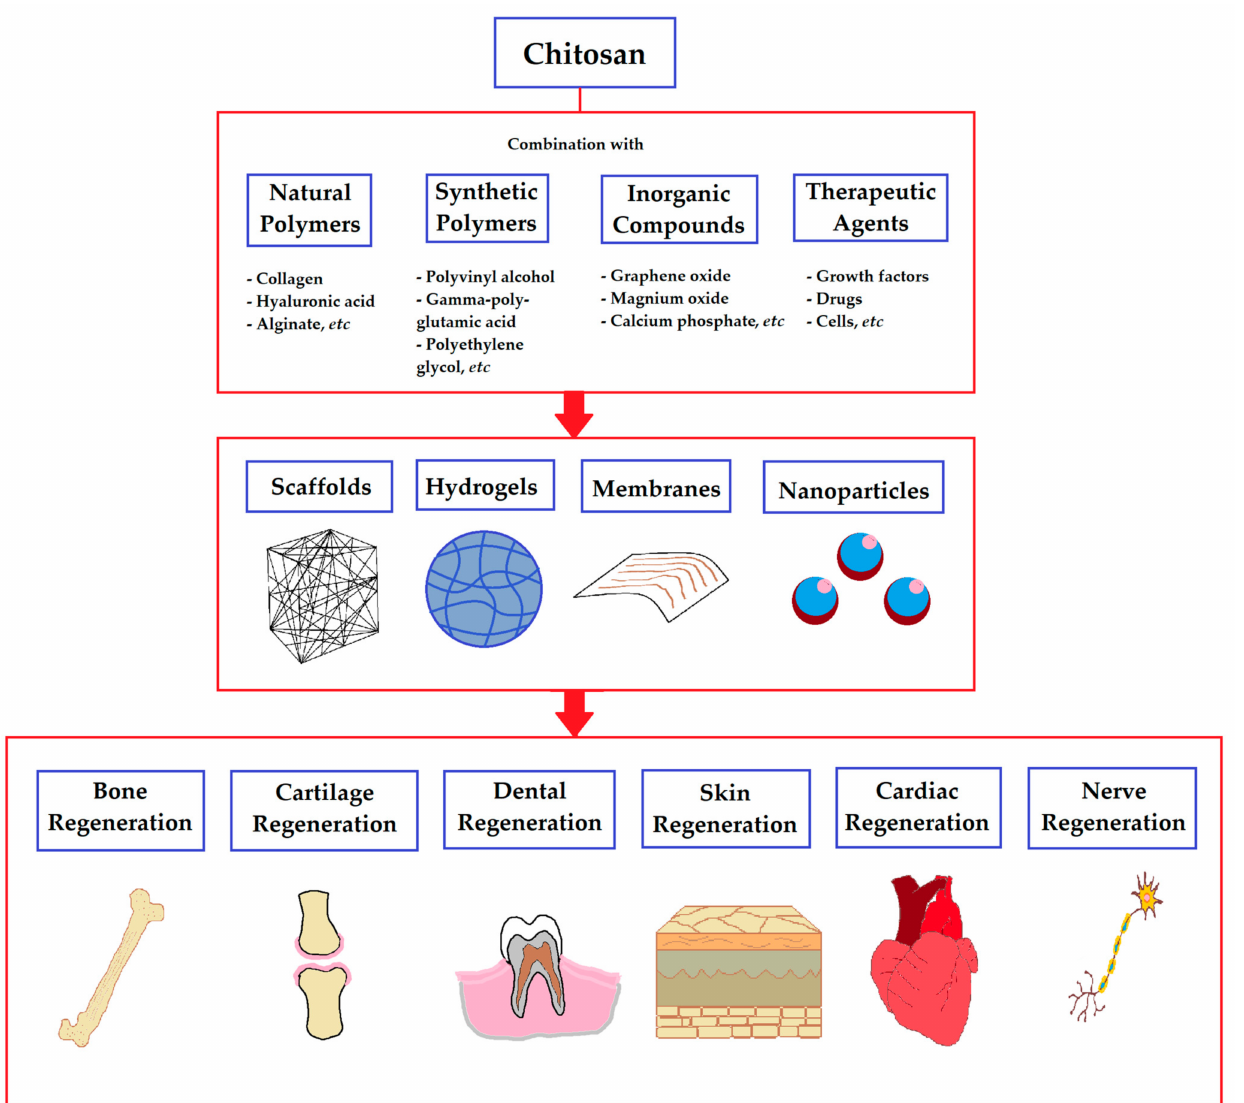
Figure 1. Use of chitosan biomaterials for tissue regeneration. Chitosan can be formulated alone or in combination with natural and synthetic polymers, inorganic compounds, and therapeutic agents into a variety of structures including scaffolds, hydrogels, membranes, and nanoparticles. These biomaterials have been demonstrated to promote regeneration and repair of bone, cartilage, dental, skin, cardiac, and nerve